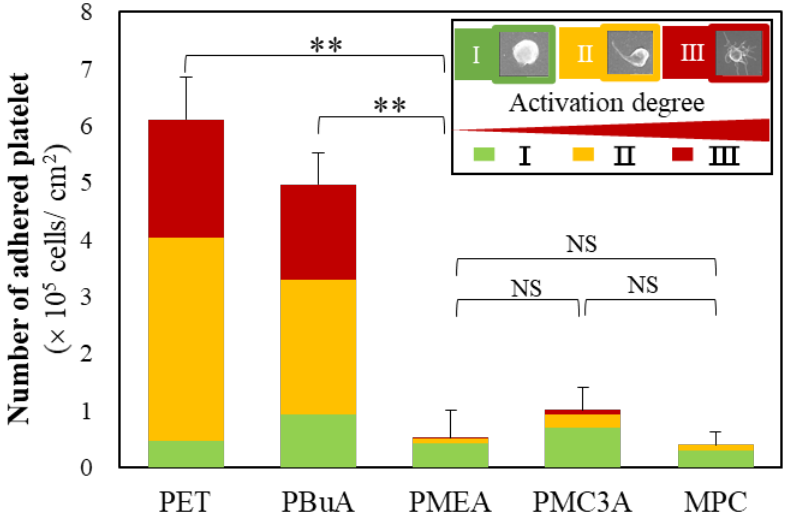
Figure 5. Summary of the human platelet adhesion experiments. Numbers of the adhered platelets on the coatings of the PMEA, PMC3A, PBA, PMPC, and bare PET. The data represent the means ± SD, n = 15, **: p < 0.01 (vs. PET) and NS = Not Significant.